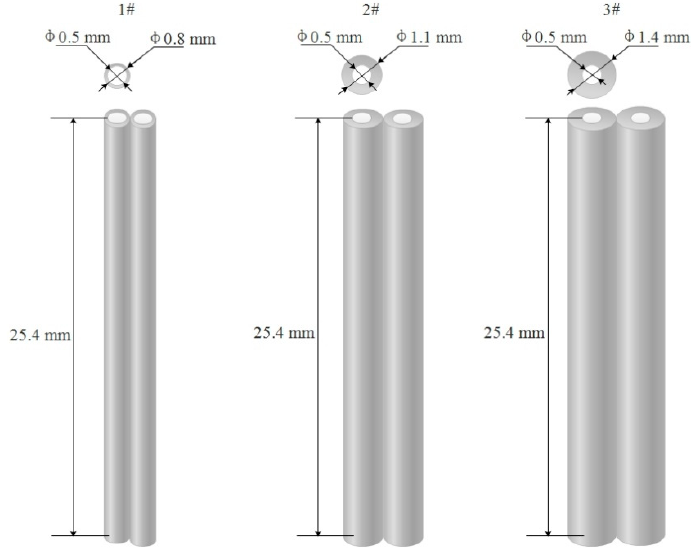
Figure 3. Schematics of spinnerets simulation in the electric field with different needle thickness.